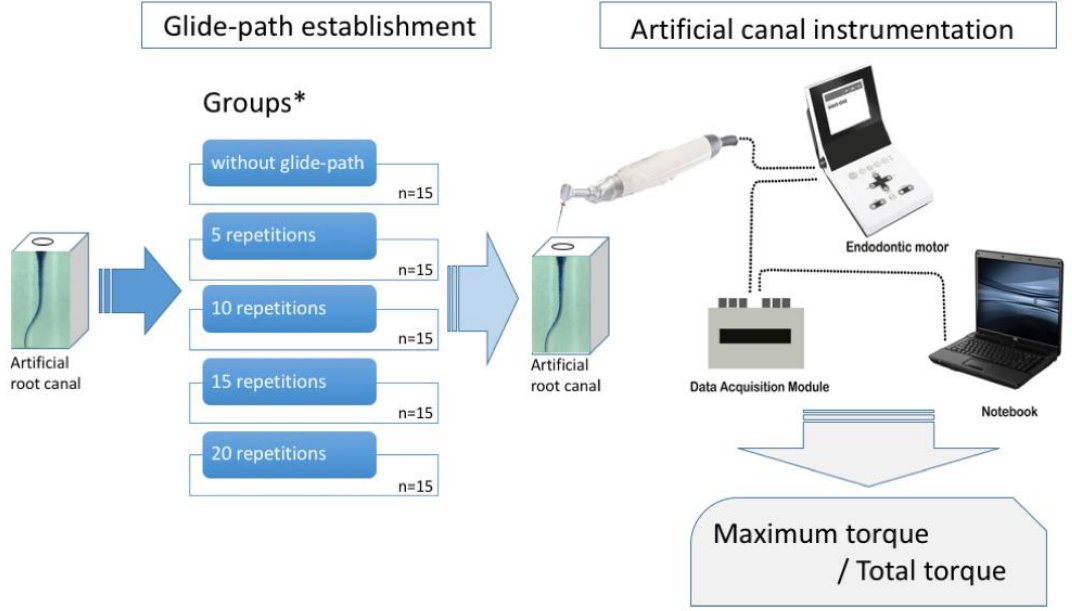
Figure 1. Experimental setting and groups (*) classification according to the number of repetitive insertions of the glide-path instrument to the working length.